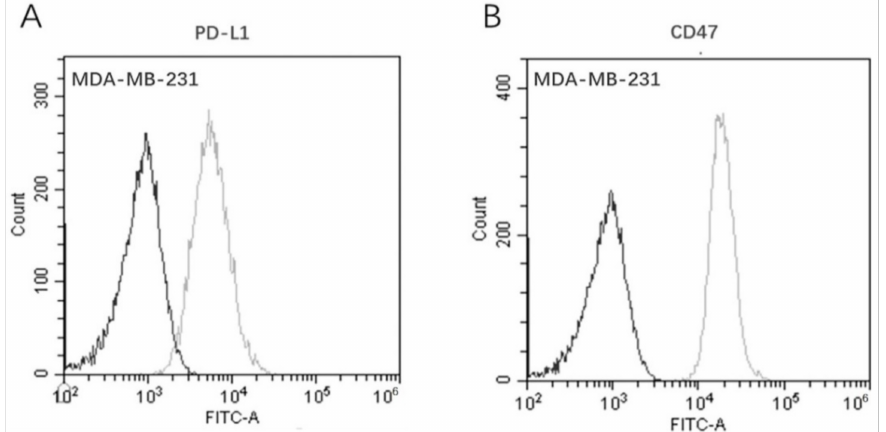
Figure 6. Co-expression of dual-targets on the TNBC cell line MDA-MB-231 by flow cytometry. ( A ) Antigen PD-L1; ( B ) antigen CD47. (Dark line: blank control; gray line: Ab-incubation